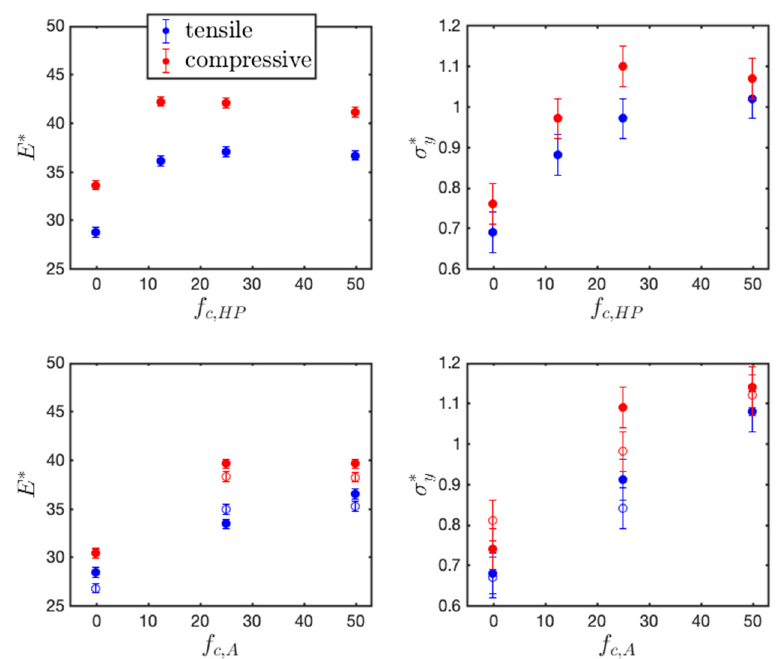
Figure 6. Extracted elastic modulus ( E and yielding stress ( σ y ) of ( top panel ) HPs and ( bottom panel ) BCPs at di ff erent charge ratio at T ∗ = 0.3 (filled symbol in parallel direction and open symbol in perpendicular direction).